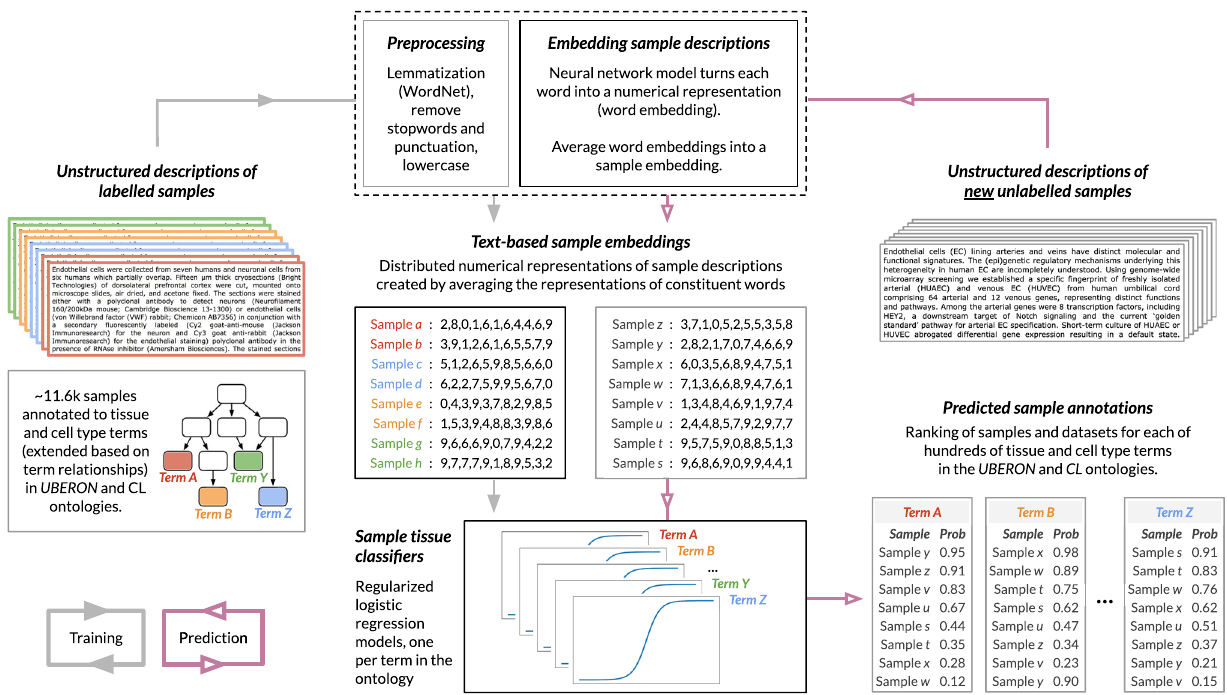
Fig. 1 | Overview of NLP-ML. The NLP-ML approach contains four steps: (i) Text preprocessing:Unstructuredmetadataofsamplesarepreprocessedtoremovetext elements extraneous to sample classi fi cation and reduce words to their roots; (ii) Creating text-based sample embeddings: A neural network model trained on large text corpora is used to create numerical embeddings of individual words. An embeddingofasampleiscreatedbyaveragingtheembeddingsofthewordsinthat sample ’ s metadata; (iii) T raining sample tissue classi fi ers: Supervised machine